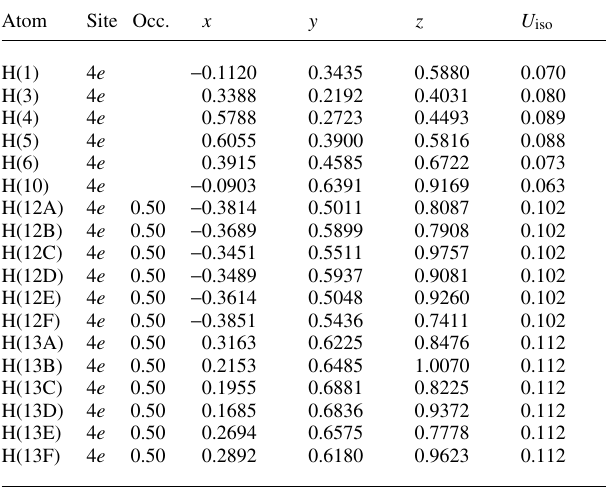
Table 2. Atomic coordinates and displacement parameters (in Å 2 )